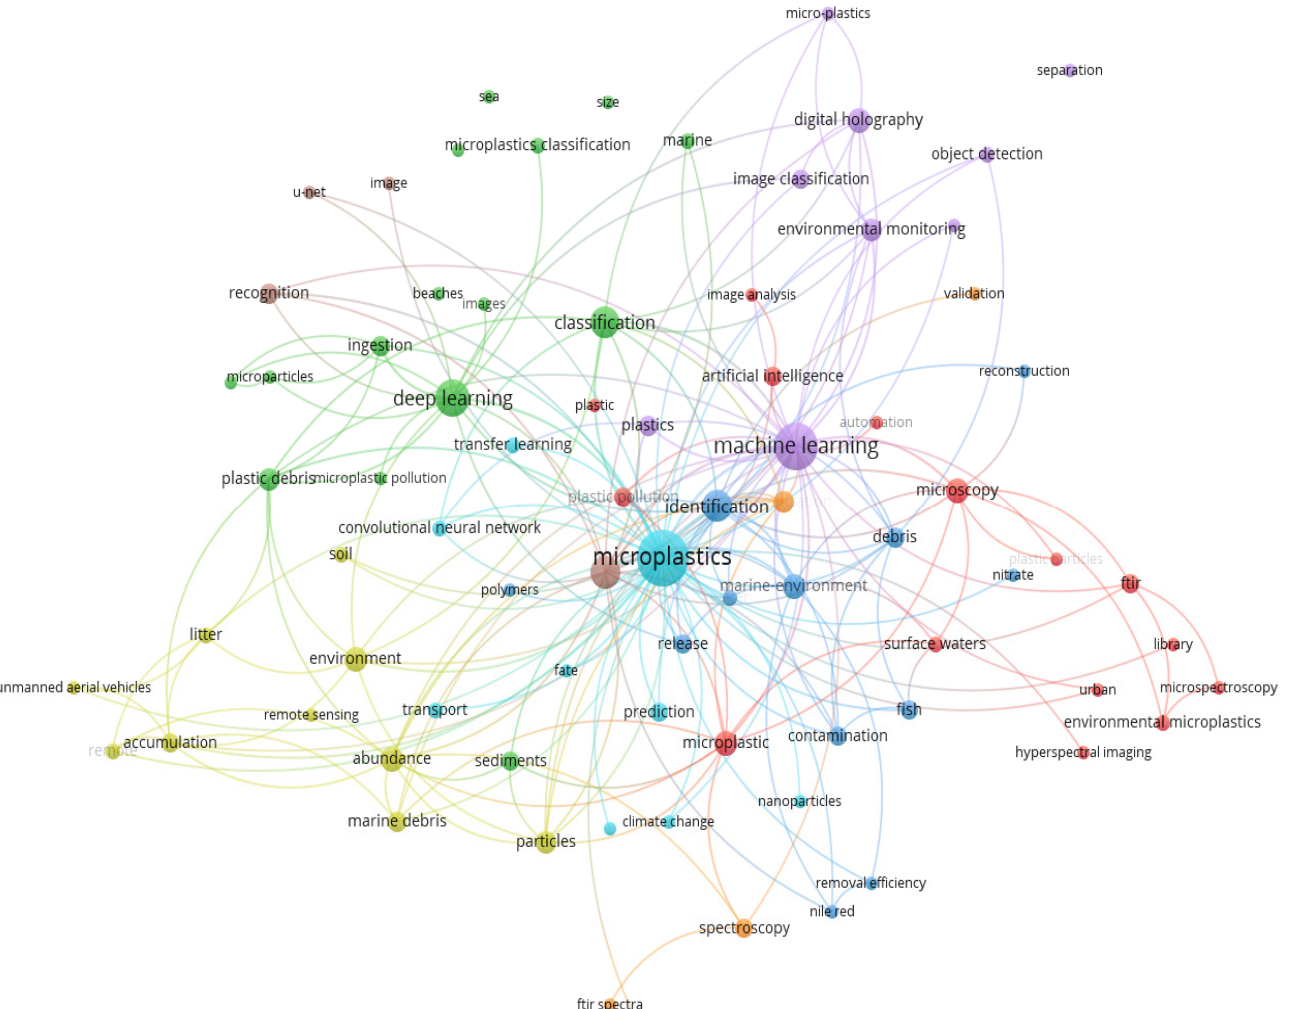
Figure 13. Keyword co-occurrence network structure (visualized with VOSviewer on data).